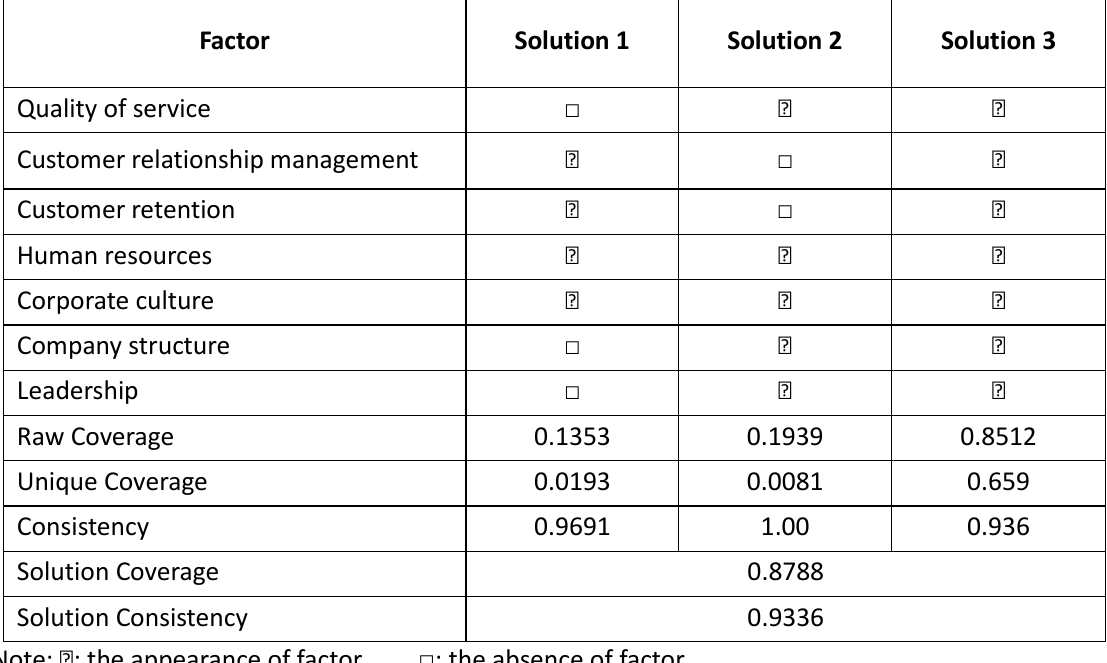
Table 1: Impact assessment of factors affecting the success of logistics enterprises (top